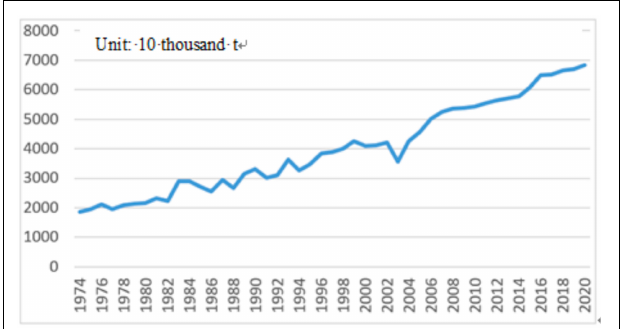
FIGURE 4 | Grain yield of Henan Province,